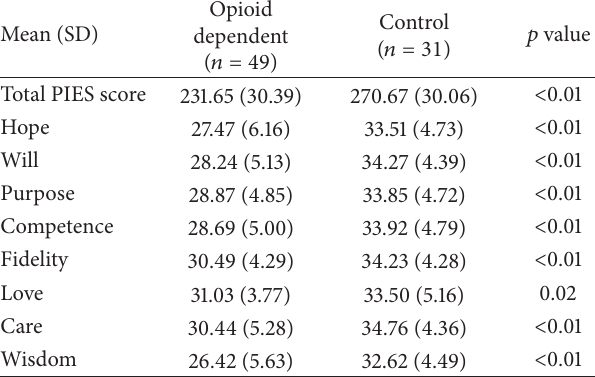
Table2:Unadjustedassociations 1 betweenPsychologicalInventory of Ego Strength (PIES) total and subscale scores and study group (opioid dependent versus